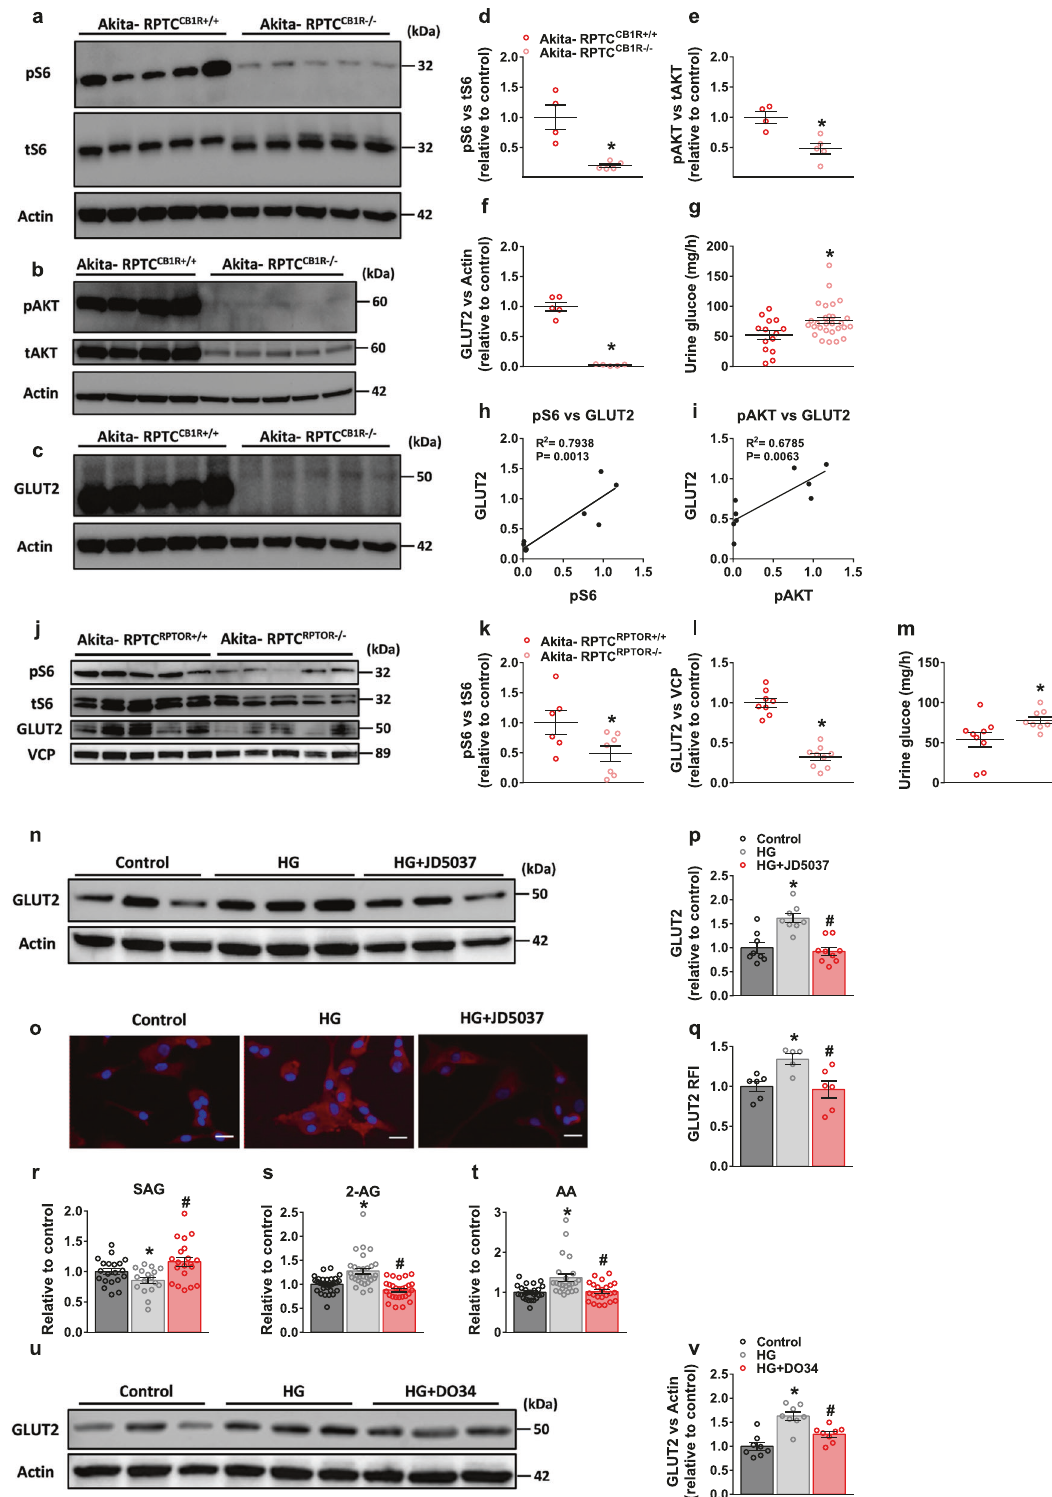
their RPTCs, on the other hand (Akita-RPTC-CB 1 R − / − -TSC + / − animals), the bene fi cial effects of CB 1 R deletion in enhancing glucosuria, reducing proteinuria and albuminuria, and improv- ing CCr were completely abrogated by partial deletion of TSC (Supplementary Fig. 3a – h), further supporting the regulatory role of CB 1 R in mTORC1 signaling and kidney